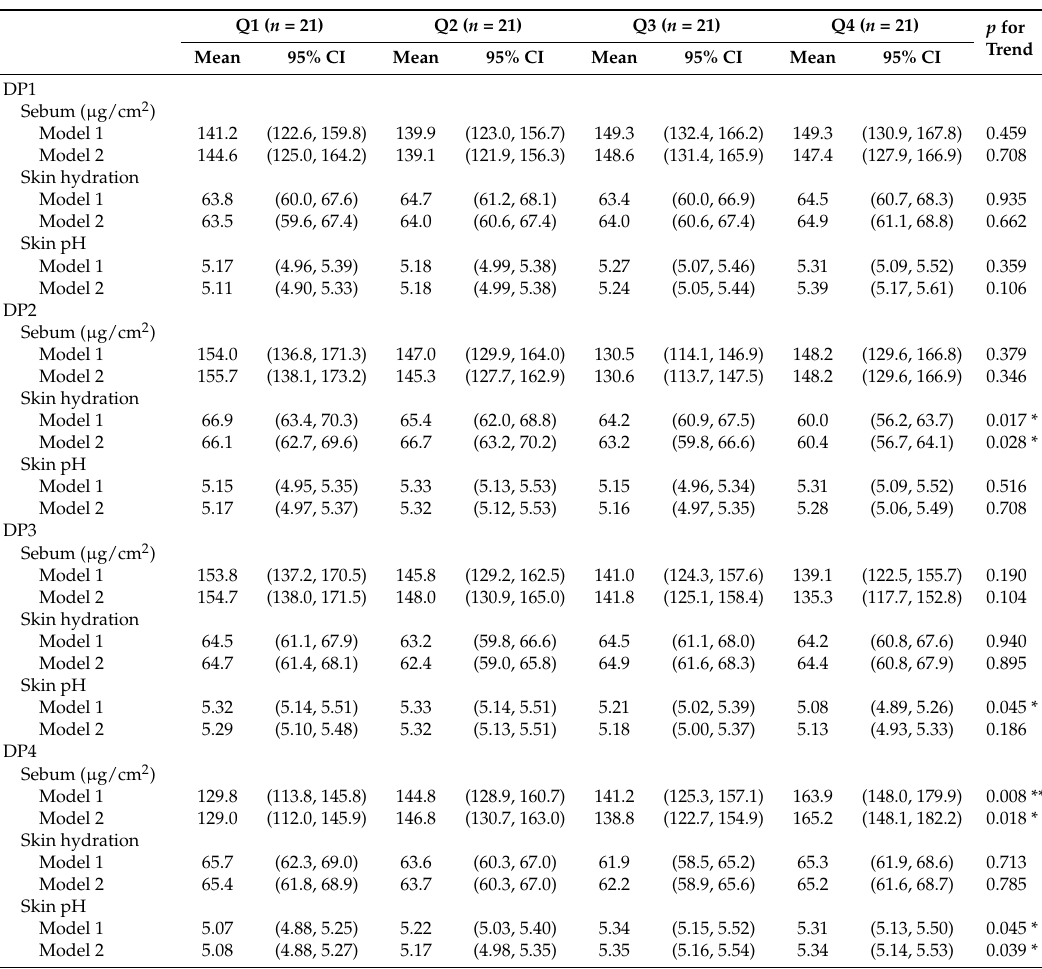
Table 3. Multivariate adjusted average of skin health parameters according to quartiles of dietary pattern scores